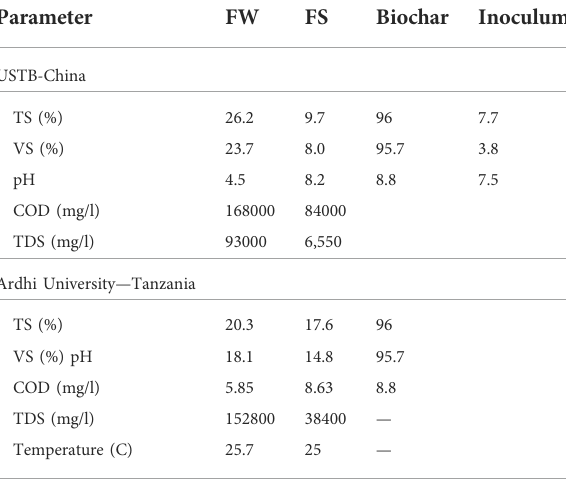
TABLE 1 Characteristics of FS, FW, and RSB at USTB, China, and Ardhi University, Tanzania. Parameter FW